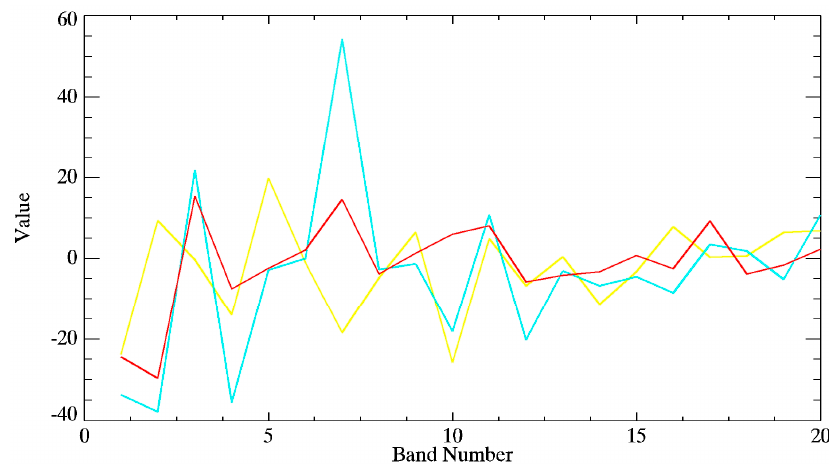
Figure 11. The spectra of the first 20 MNF bands collected at three pure pixels (annotated in Figure 12) of Avicennia marina (red), Lumnitzera racemosa (yellow) and Rhizophora mucronata (cyan). The spectral difference among the three species of mangroves is most apparent at bands 2, 7 and 10, which are, therefore, designated as the red, green and blue channels to make a false-color composite, as annotated by the three vertical red, green and blue lines. Remote Sens. 2019 , 11 , x FOR PEER REVIEW